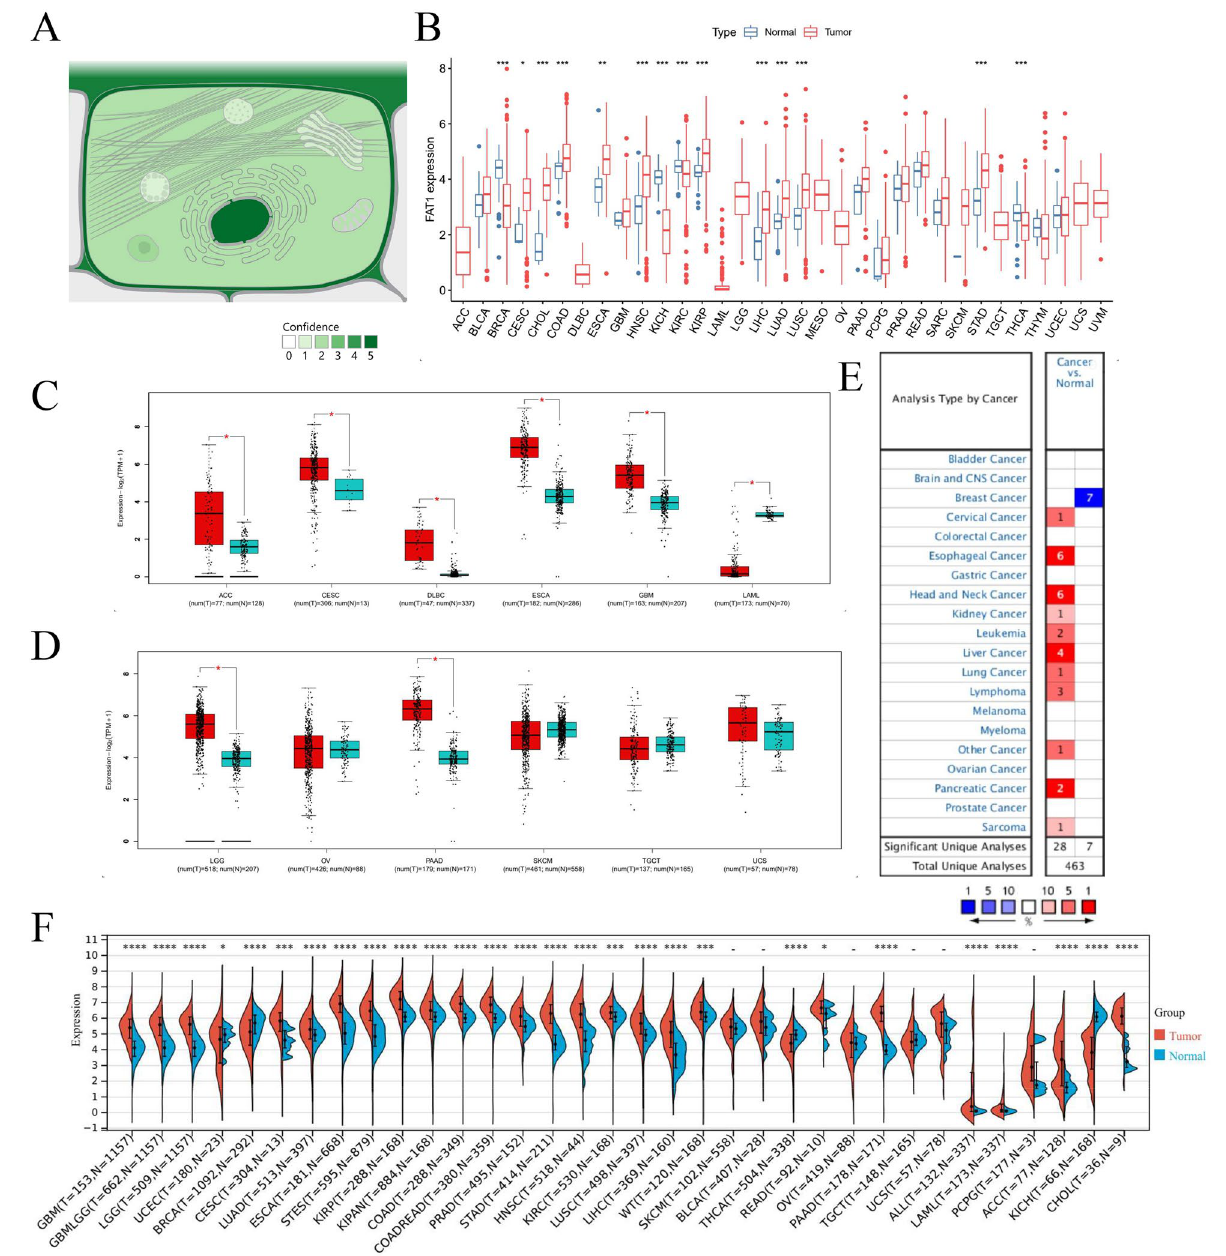
Figure 1. Subcellular locations and mRNA expression levels of FAT1. ( A ) Subcellular locations of FAT1 based on protein expression. ( B ) mRNA expression levels of FAT1 in pan-cancer. ( C , D ) mRNA expression levels of FAT1 in 12 tumors. ( E ) FAT1 expression levels in the dataset of 20 tumors in the Oncomine database. The best gene rank percentile determines the cell color for the analyses within the cell. The red indicates high expression, and the blue indicates low expression. ( F ) mRNA expression of FAT1 in pan-cancer from the Sangerbox